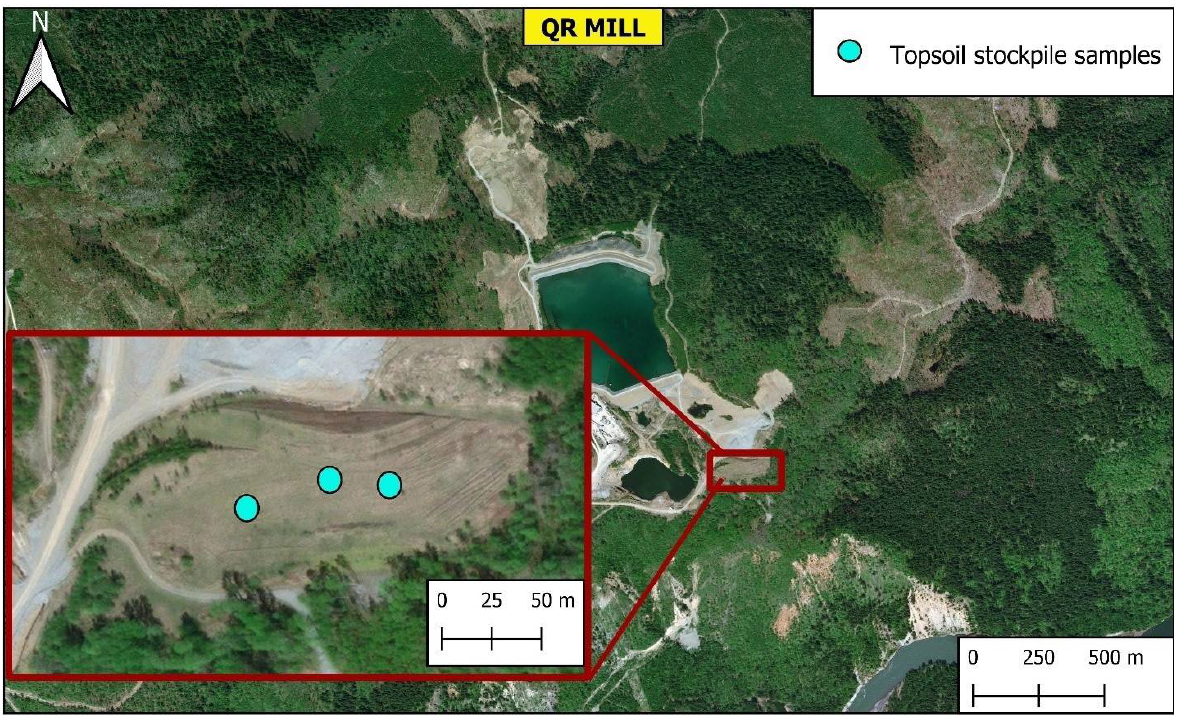
Figure 2. Aerial image of the QR mill, including a close-up of the topsoil stockpile of interest that shows the locations of three soil pit samples. Map generated in QGIS ® with Bing VirtualEarth back- ground.